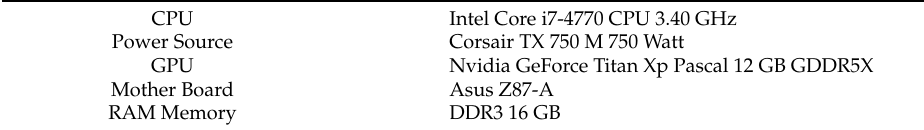
Table 4. Hardware specifications.